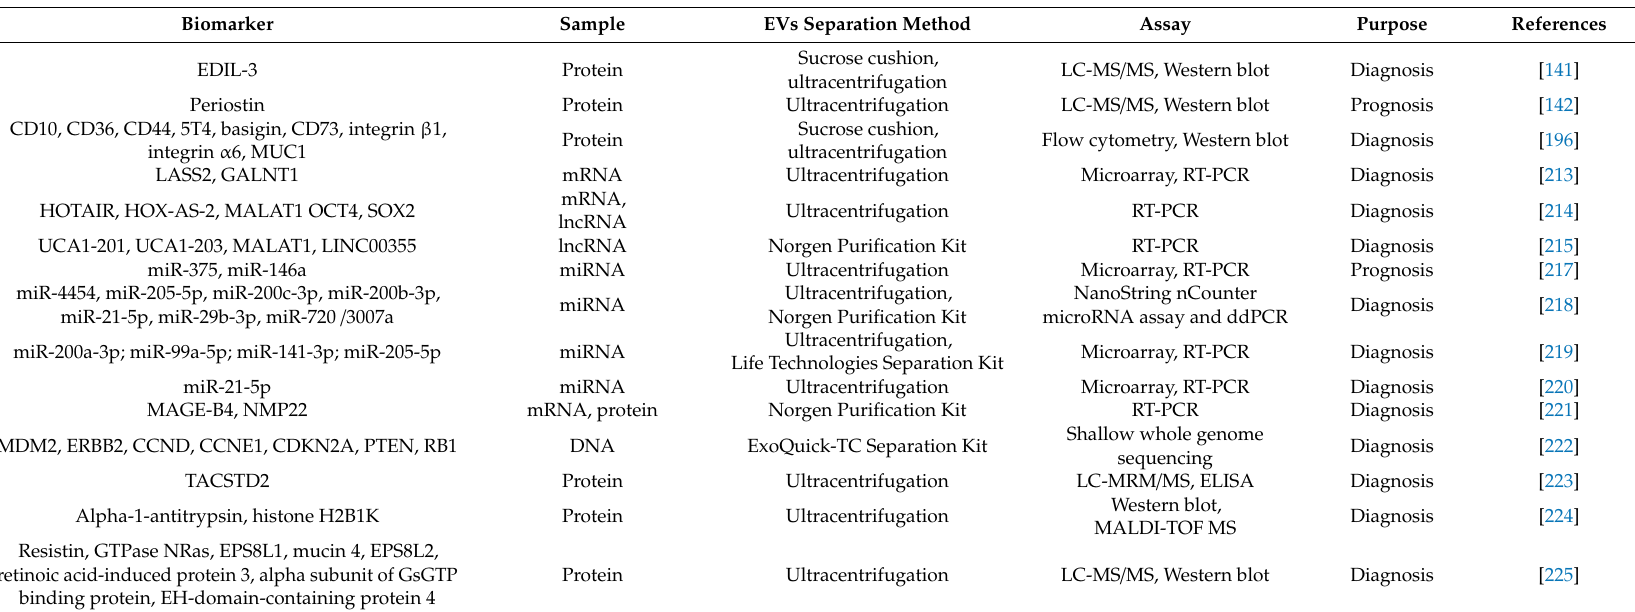
Abbreviations: LC-MS / MS: liquid chromatography-mass spectrometry; RT-PCR: reverse transcription polymerase chain reaction; LC-MRM / MS: liquid chromatography-multiple reaction monitoring mass spectrometry; MALDI-TOF MS: matrix assisted laser desorption ionization-time of flight mass spectrometry; mRNA: messenger RNA; miRNA: micro RNA; lncRNA: long non-coding